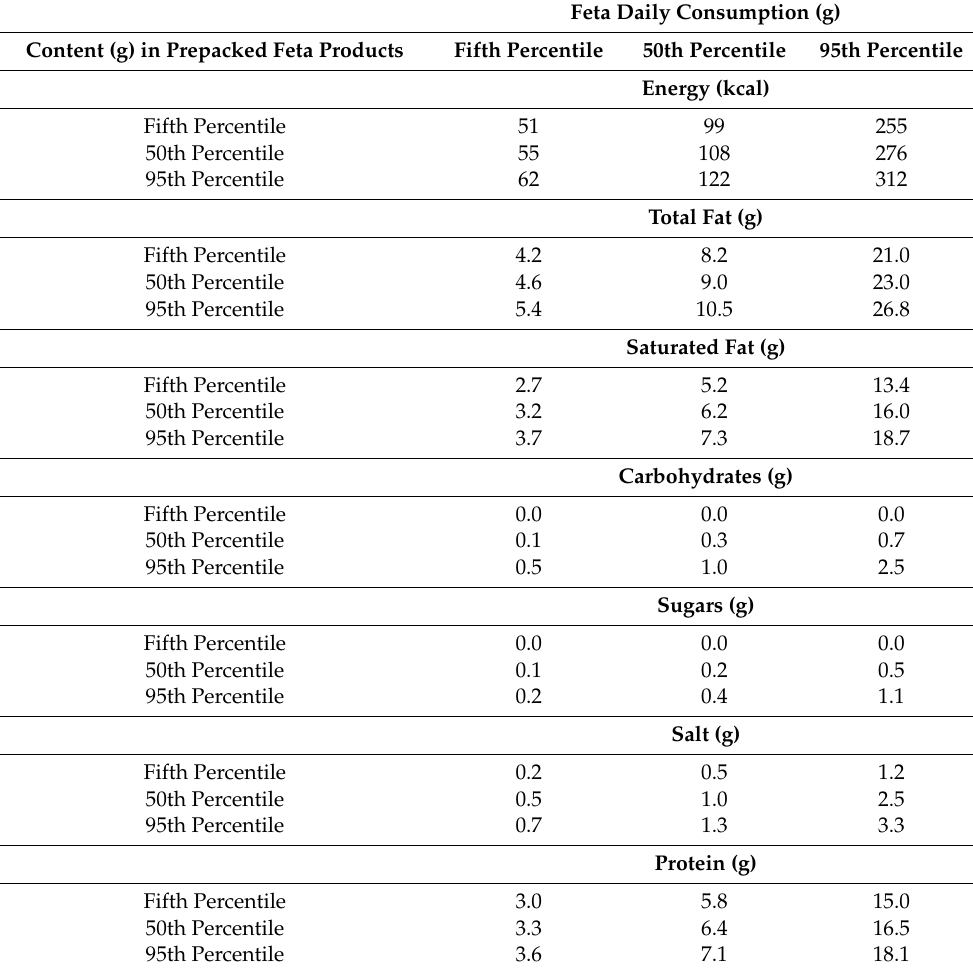
Figure 2. Frequency histogram of Greek adults’ feta cheese consumption (g) per capita and per day based on data 1232 healthy adult Greek consumers extracted from the Hellenic National Nutrition & Health Survey (HNNHS) database. Table 4. Nutrient daily intake (kcal or g) from prepacked feta cheese consumption marketed in the Greek market as a ff ected by product content and daily consumption by Greek